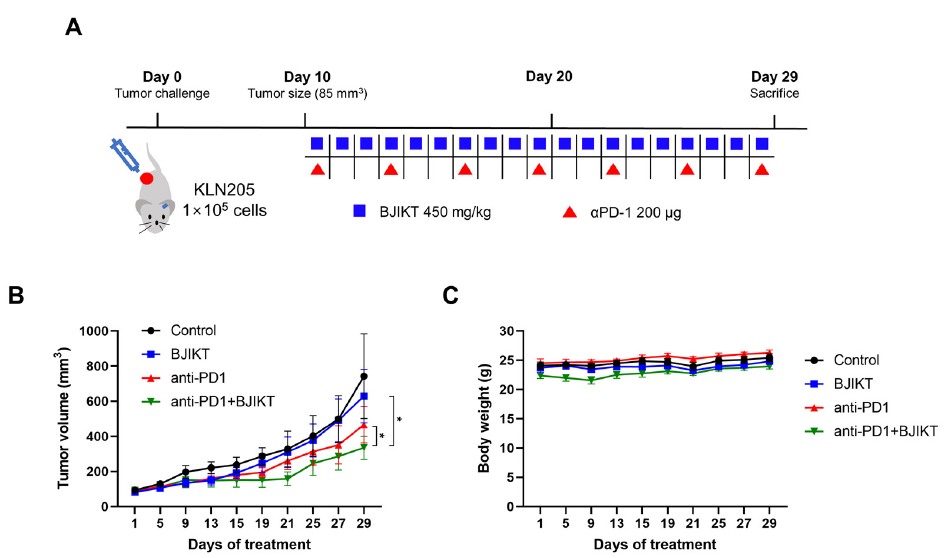
Figure 1. BJIKT treatment enhances the response to anti-PD-1 immunotherapy in KLN205 tumor- bearing DBA/2 mice. The tumor was established through a subcutaneous injection of 1 × 10 5 KLN205 cells in mice. Ten days after the injection, the mice were divided into four groups: control, BJIKT, anti-PD-1 antibody, and combination (BJIKT and anti-PD-1 antibody). A dose of 450 mg/kg BJIKT was orally administrated daily, and 200 μ g of anti-PD-1 antibody was intraperitoneally administered every three days. ( A ) Experimental scheme with the timeline of treatment in mice. ( B ) Tumor volume in KLN205 tumor-bearing mice. Tumor sizes were measured three times a week. ( C ) Body weight changes in KLN205 tumor-bearing mice. Data are represented as the mean ± SD ( n = 5). * p < 0.05, compared to the combination group.